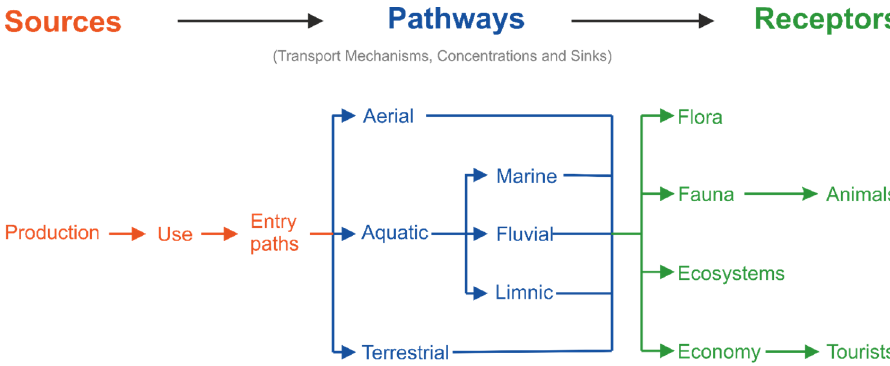
Figure 8. Source–Pathway–Receptor Model applied on macroplastic in the environment (inspired by [16]).